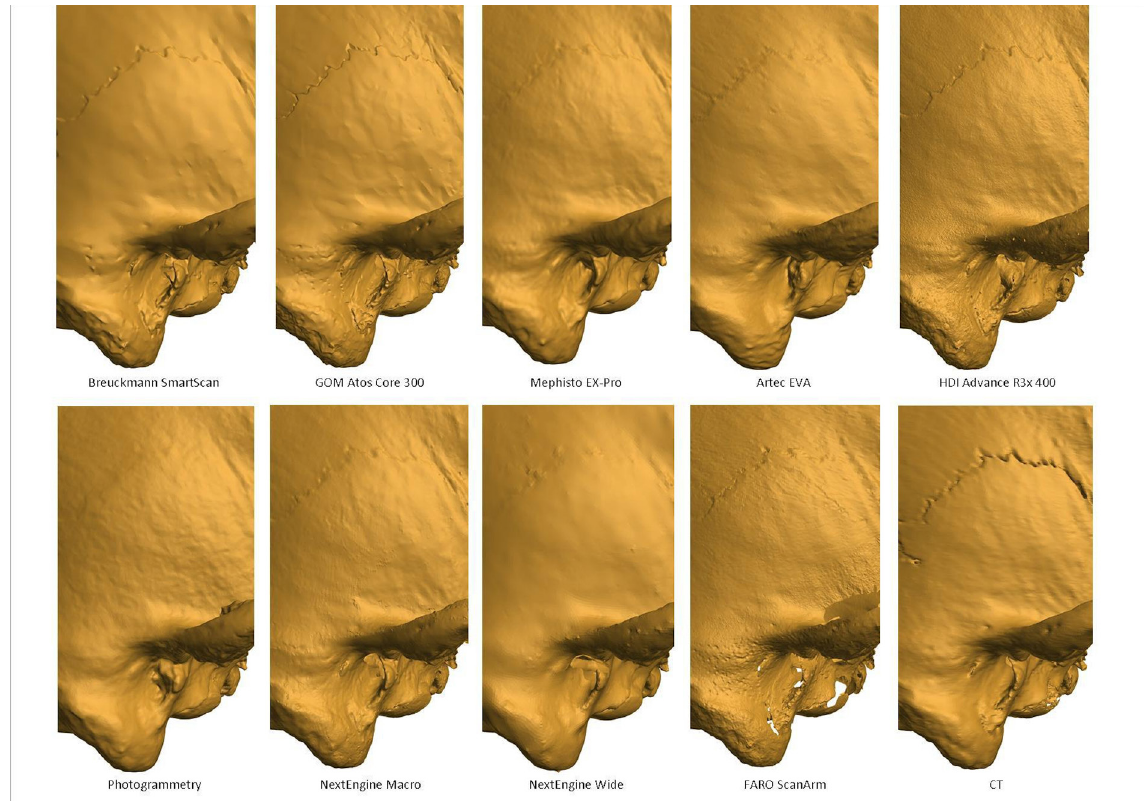
Fig. 6.4. Parietal view of the skull digitised with different